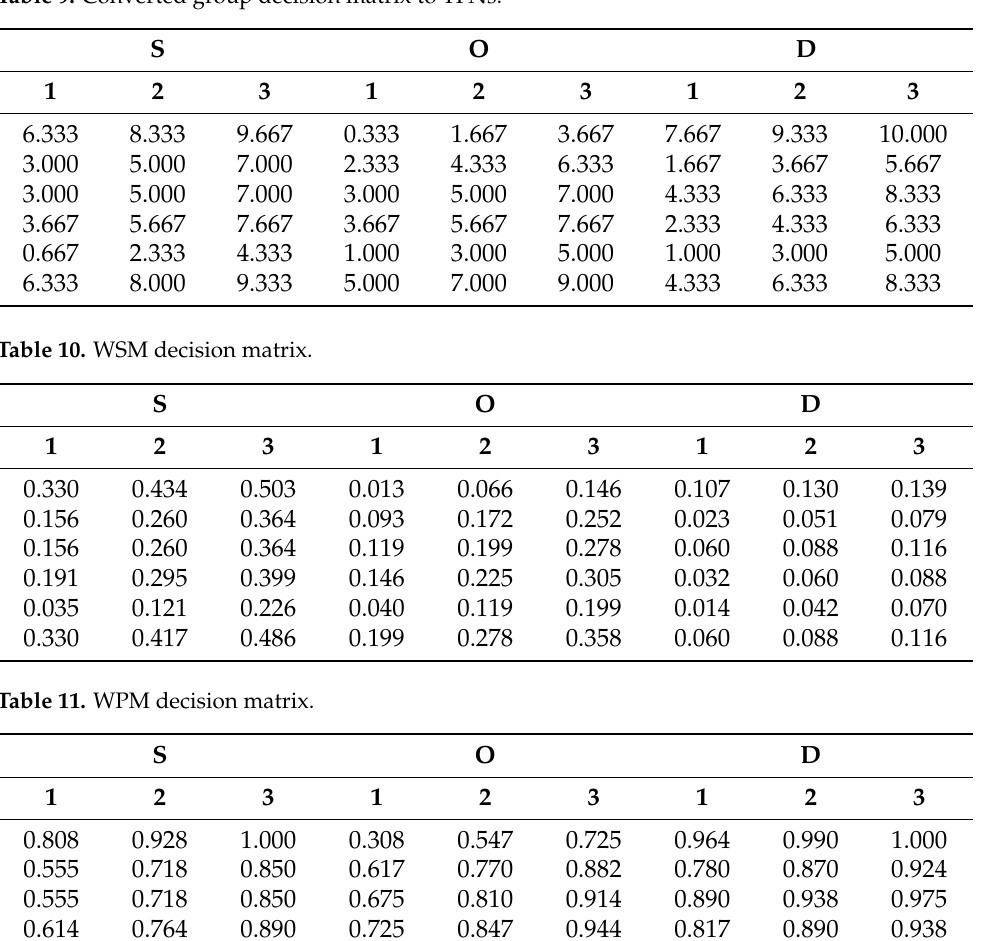
Table 9. Converted group decision matrix to TFNs.